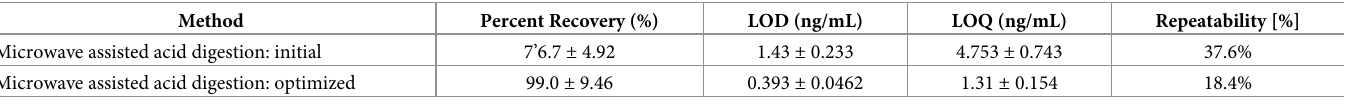
Table 4. Comparison between the optimized and initial microwave assisted acid digestion procedure with respect to recovery rates, limits of detection (LOD), limits of quantification (LOQ), and repeatability expressed as relative standard deviation between measurements.